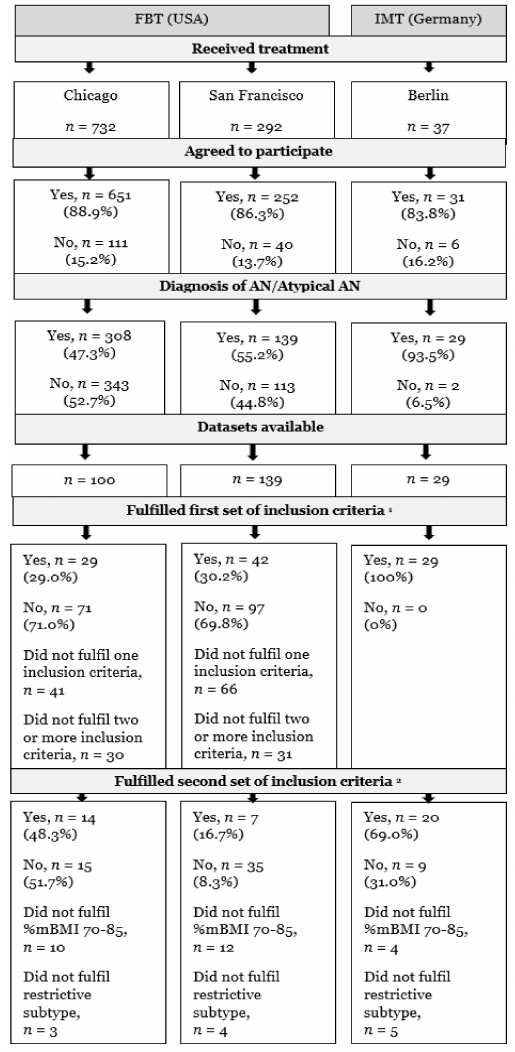
Figure 1. Flowchart of recruitment and data inclusion procedure. AN, anorexia nervosa; FBT, family-based treatment with/without medical stabilization as needed; IMT, inpatient multimodal treatment followed by outpatient care; %mBMI, percent median body mass index; 1 aged between 12 and 18 years, participation in weight measurements at baseline and 6-month follow-up, completed baseline questionnaire of eating disorder psychopathology, available data on the duration of illness and psychiatric comorbidities; 2 %mBMI 70–85 and restrictive